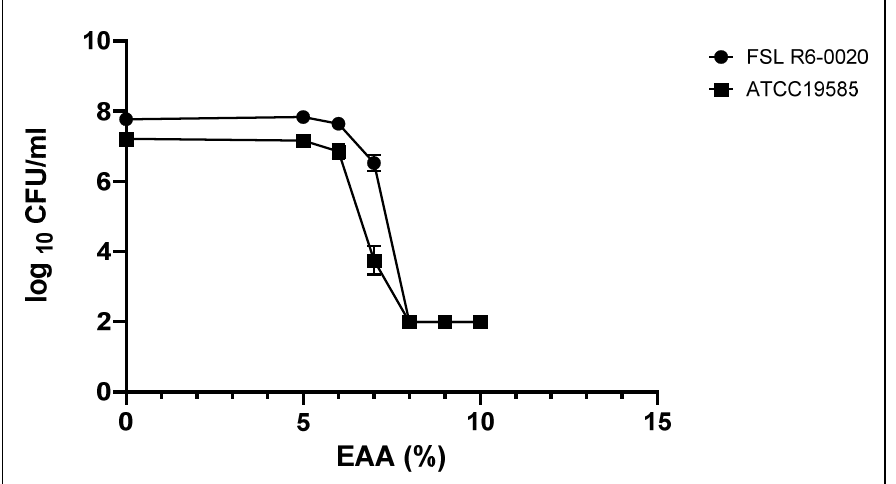
Figure 1. Concentration dependence of the survival of Salmonella after 5 min of incubation with EAA. Data are expressed in CFU/mL from three replicate experiments.